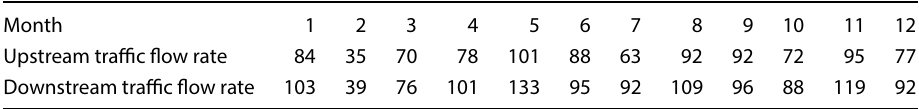
Table 1 Average monthly daily ship traffic flow rate of Jingzhou Yangtze River Bridge in 2013 (ves/day)